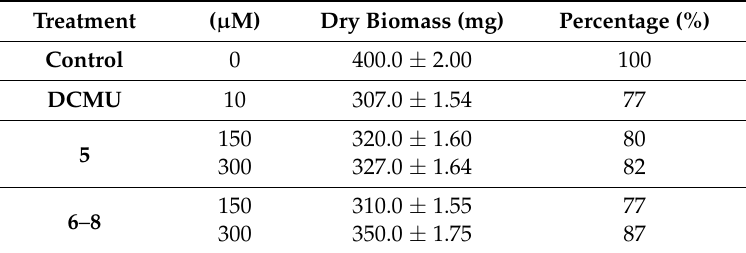
Table 4. Dry biomass assay for Compounds 5 and 6 – 8 . Note: DCMU,